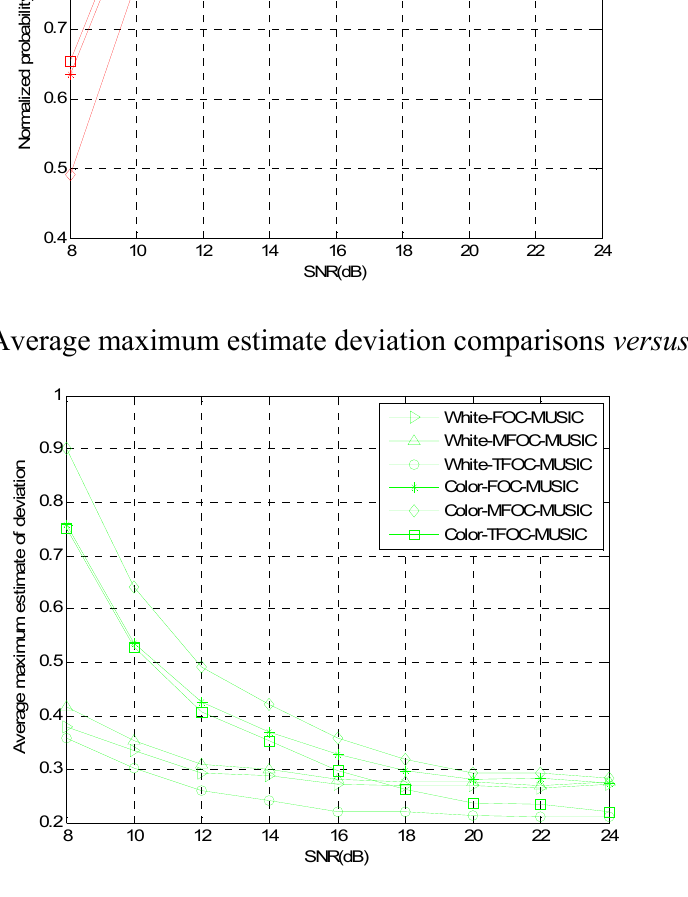
Figure 4. Average estimate variance comparisons versus